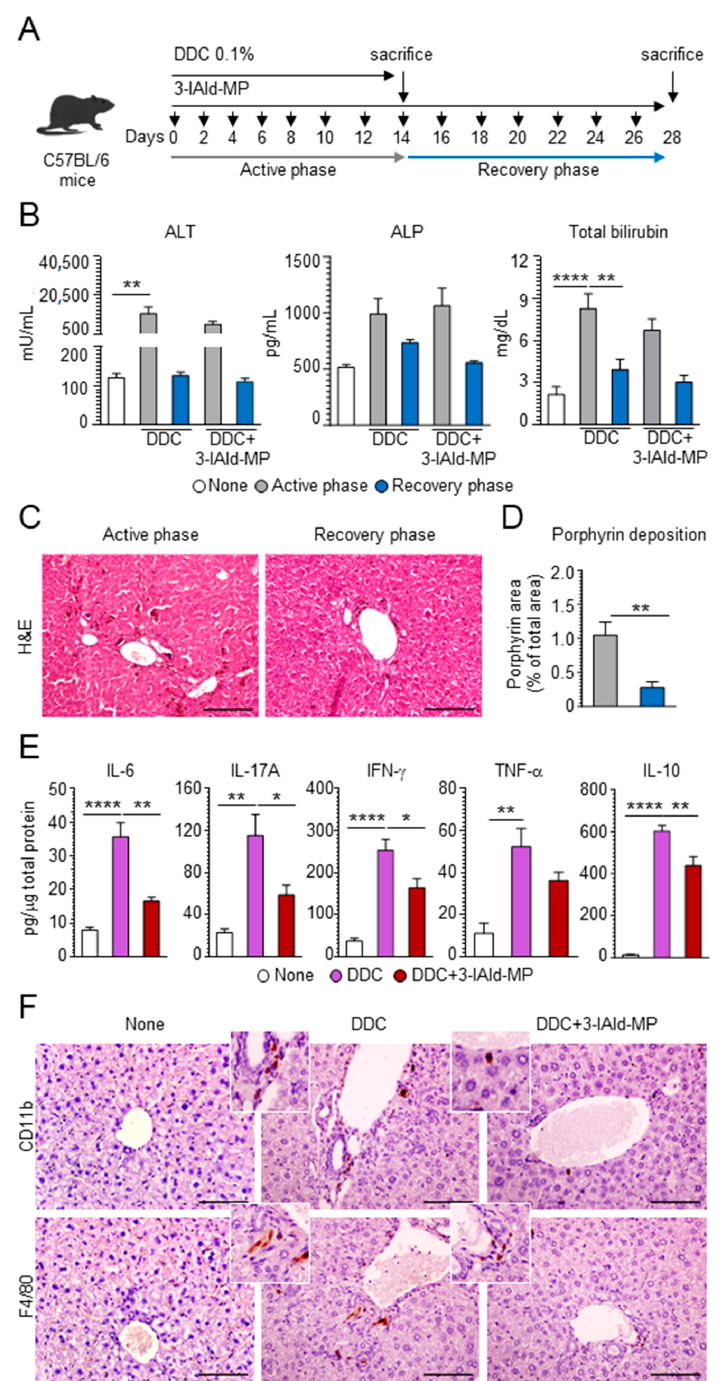
Figure 2. 3-IAld-MP reduces liver inflammation. C57BL/6 mice were fed for 14 days with a 0.1% DDC-containing diet (active phase) and subjected to a recovery time of 14 days (recovery phase). The mice were treated intragastrically with 3-IAld-MP every other day throughout the experiment, as depicted in the experimental schedule ( A ). The mice were evaluated for ( B ) serum levels of alanine aminotransferase (ALT), alkaline phosphatase (ALP), and total bilirubin, ( C ) liver histopathology by H&E, ( D ) porphyrin deposition, ( E ) cytokine production by ELISA, and ( F ) liver CD11b + and F4/80 + cells by immunohistochemistry. Photographs were taken with a high-resolution microscope (Olympus BX51), 40 × magnification (scale bars, 100 µ m). The data are presented as the mean ± SEM and are representative of three experiments ( n = 4 mice/group). * p < 0.05, ** p < 0.01, **** p < 0.0001, DDC-treated vs. untreated (none) mice, and DDC vs. DDC + 3-IAld-MP. One-way ANOVA, Bonferroni post-test, and two-tailed Student’s